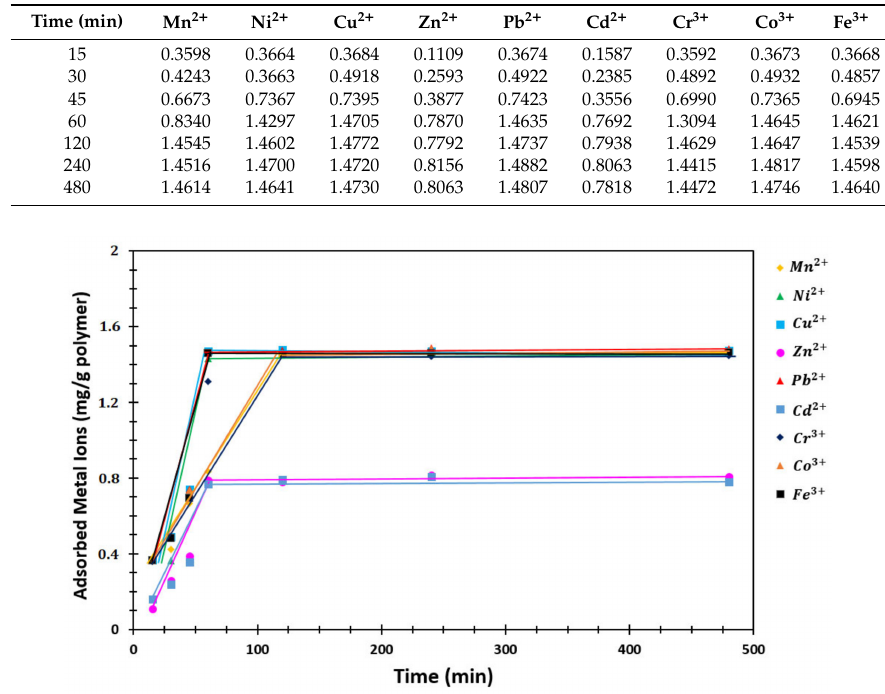
Figure 8. The sorption rate graph on the SAP against di ff erent adsorption times of the metal ions (mg / g polymer).